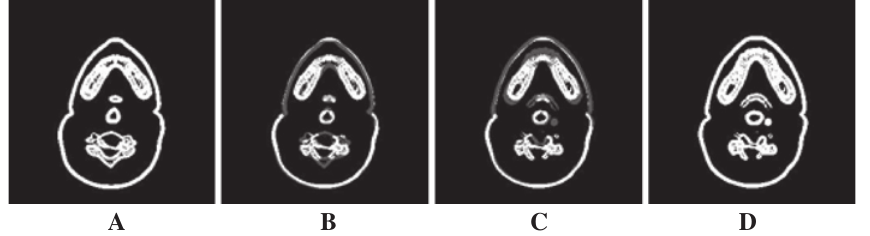
Figure 4: Re-creation of slices using linear interpolation. (B and C) are re-created slices by applying linear interpolation to the selected segmented slices (A and D).